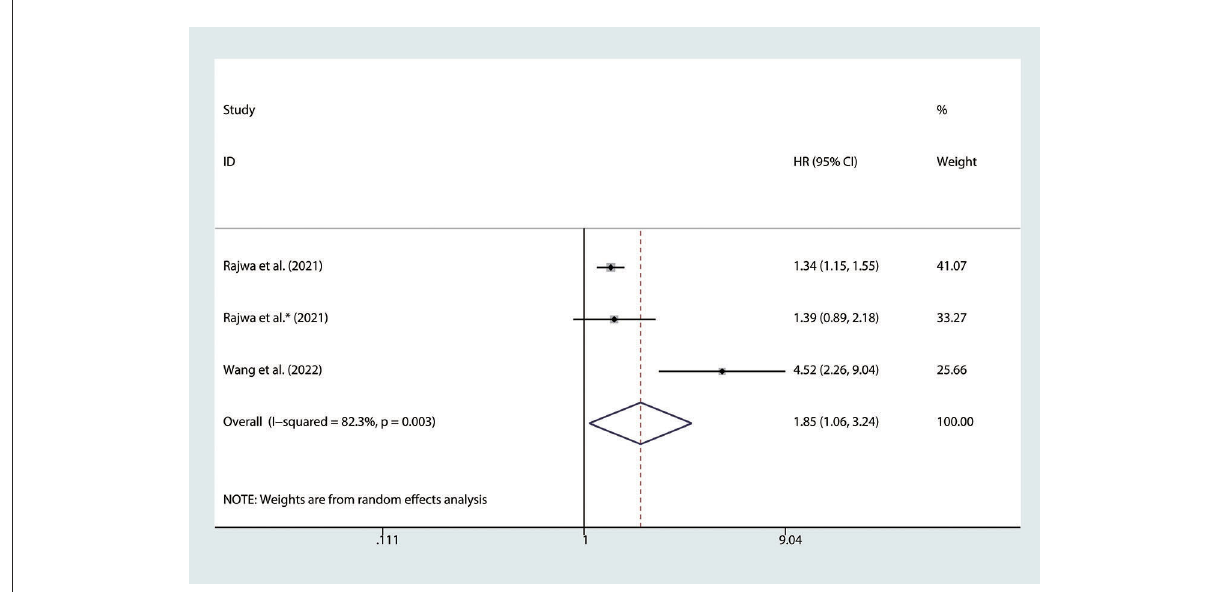
FIGURE4 Forest plot of the association between SII and BFS in nmPCa patients with prostate cancer. SII, systemic immune-inflammation index; BFS, biochemical recurrence-free survival; nmPCa, non-metastatic prostate